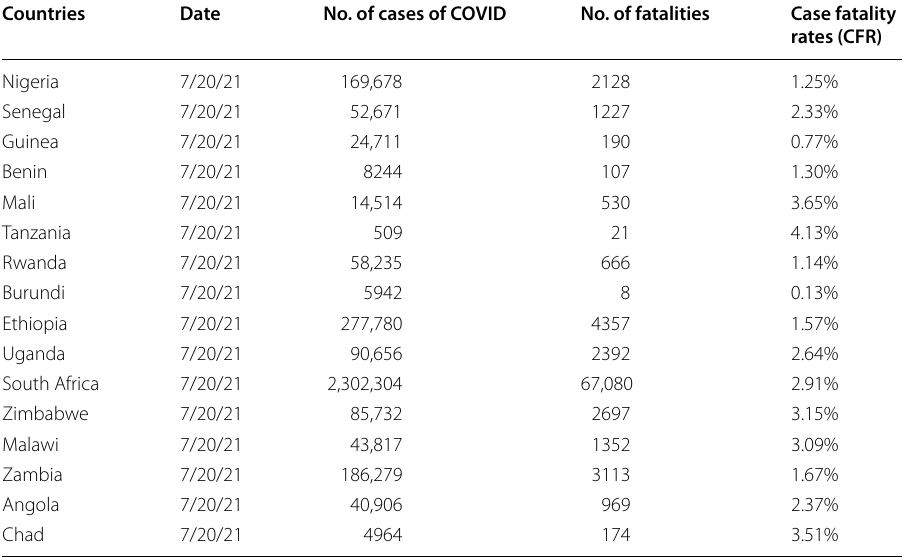
Source: World Health